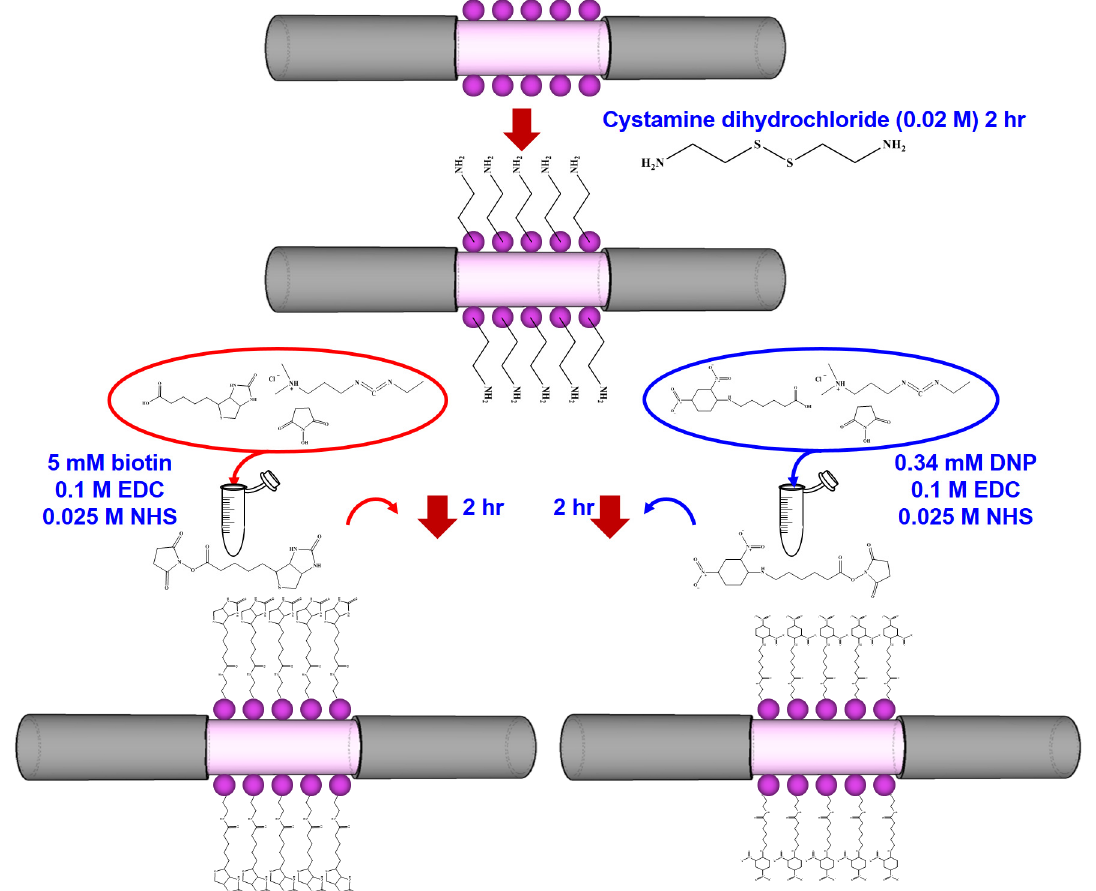
Figure 4. Schematic representation of the biofunctionalize setup of the optic probe. DNP: dinitrophenyl-epsilon-aminocaproic acid; EDC: 1-ethyl-3-(3-dimethylaminopropyl) carbodiimide hydrochloride; NHS: N-hydroxy-succinimide.